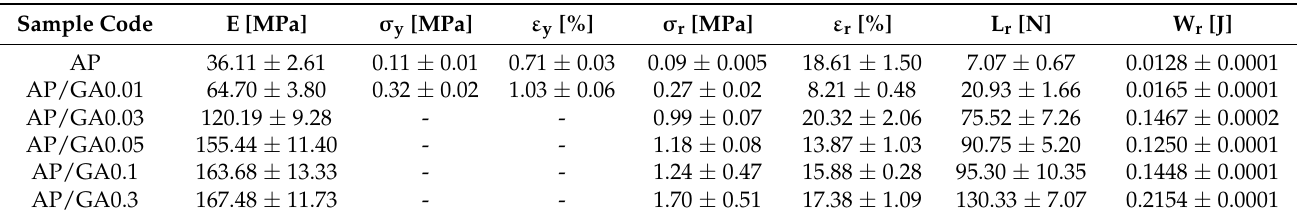
Table 3. Mechanical characterization of AP and AP/GA